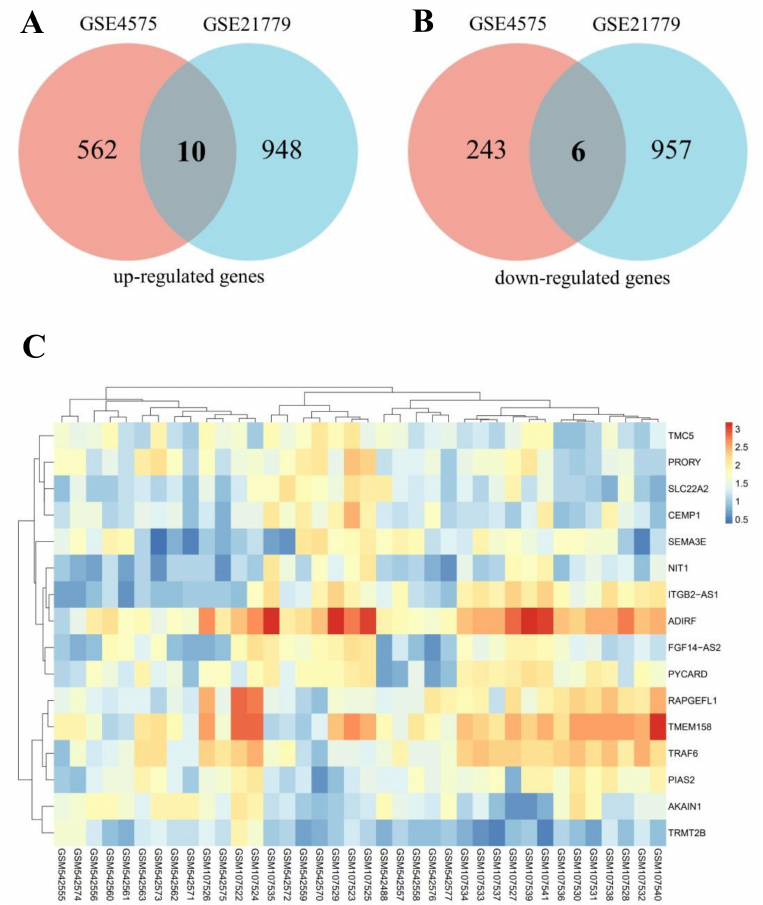
Figure 2. Identification of DEGs. ( A ) The Venn diagram of 10 up-regulated genes; ( B ) The Venn diagram of 6 down-regulated genes; The pink represents GSE4575 dataset and blue represents GSE21779 dataset; ( C ) The heatmap image of 16